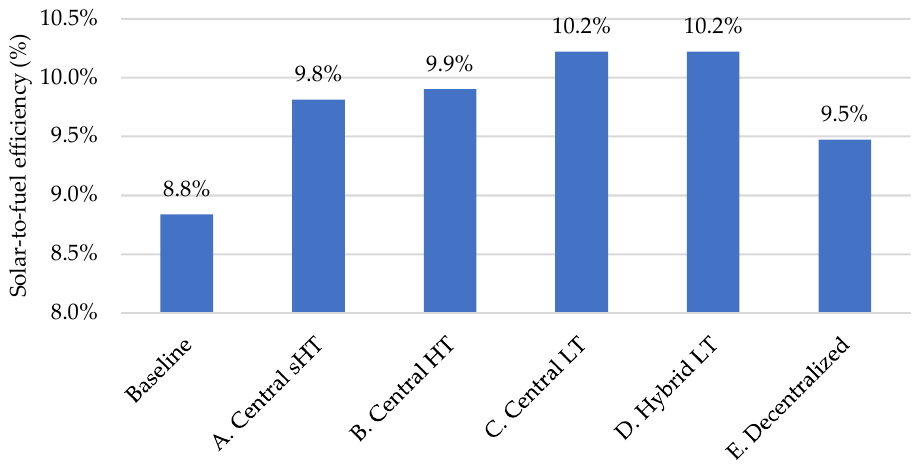
Figure 12. Comparison of solar-to-fuel efficiency for each scenario and baseline.